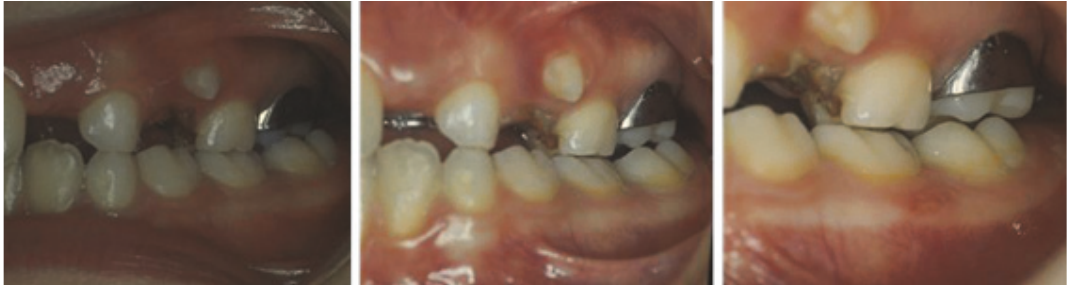
Figure 8: Rapid resolution of crossbite of tooth